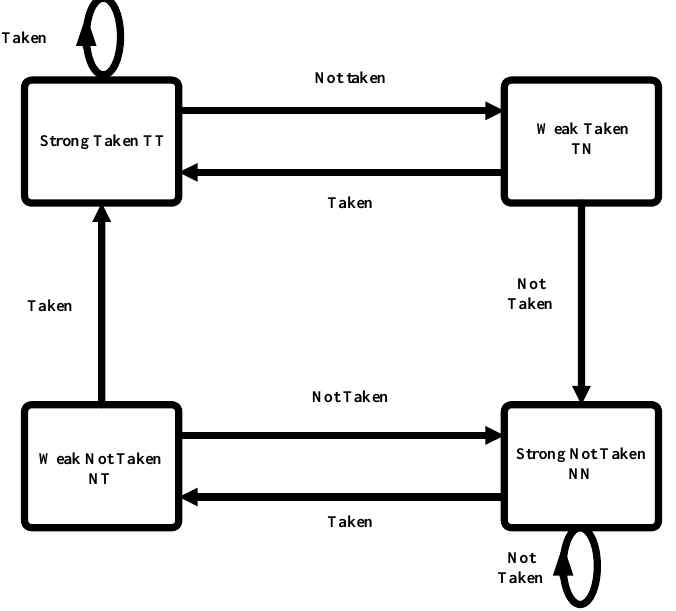
Figure 2. Diagnostic diagram of condition